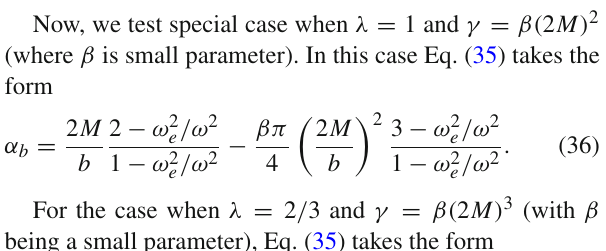
ω 2 /ω 2 ,β and b in the uniform plasma, b for different value e λ = 1